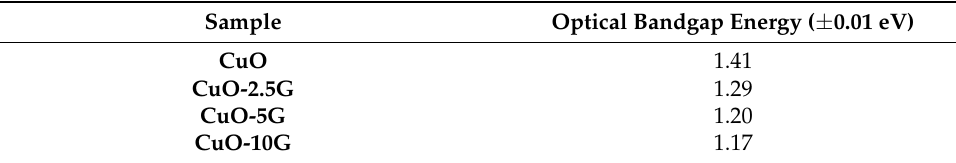
Figure 7. Tauc’s plots of the samples: ( a ) CuO, ( b ) CuO-2.5G, ( c ) CuO-5G, ( d ) CuO-10G. Table 7. Calculated optical bandgap energies for the synthesized